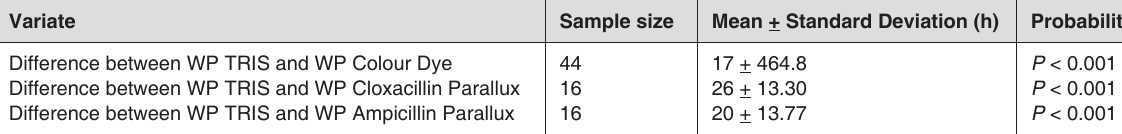
TABLE 2 Withdrawal periods (WPs) measured by different methods (Curaclox LC; Trials 1 and 3) Variate Sample size Mean + Standard Deviation (h) Probability Difference between WP TRIS and WP Colour Dye Difference between WP TRIS and WP Cloxacillin Parallux Difference between WP TRIS and WP Ampicillin Parallux